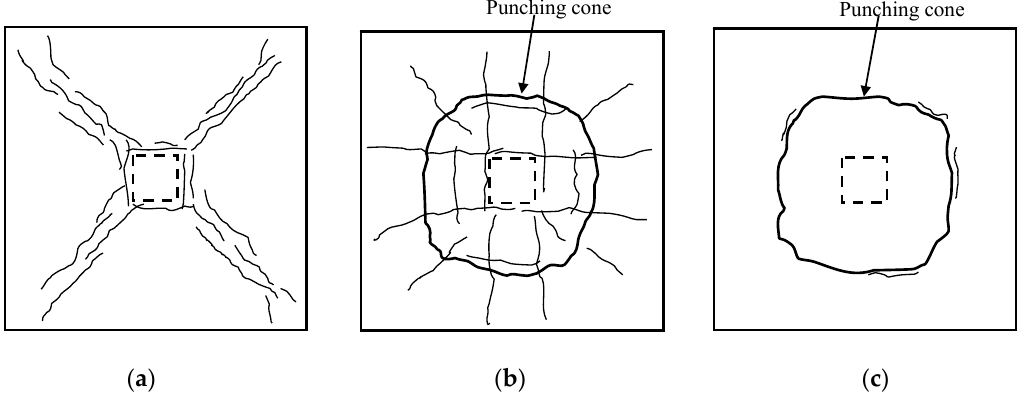
Figure 5. Typical cracking patterns on the tension surface of the slab: ( a ) Flexural failure; ( b ) Punching shear failure of slabs without CFRP laminates; ( c ) Punching shear failure of slabs with CFRP laminates.